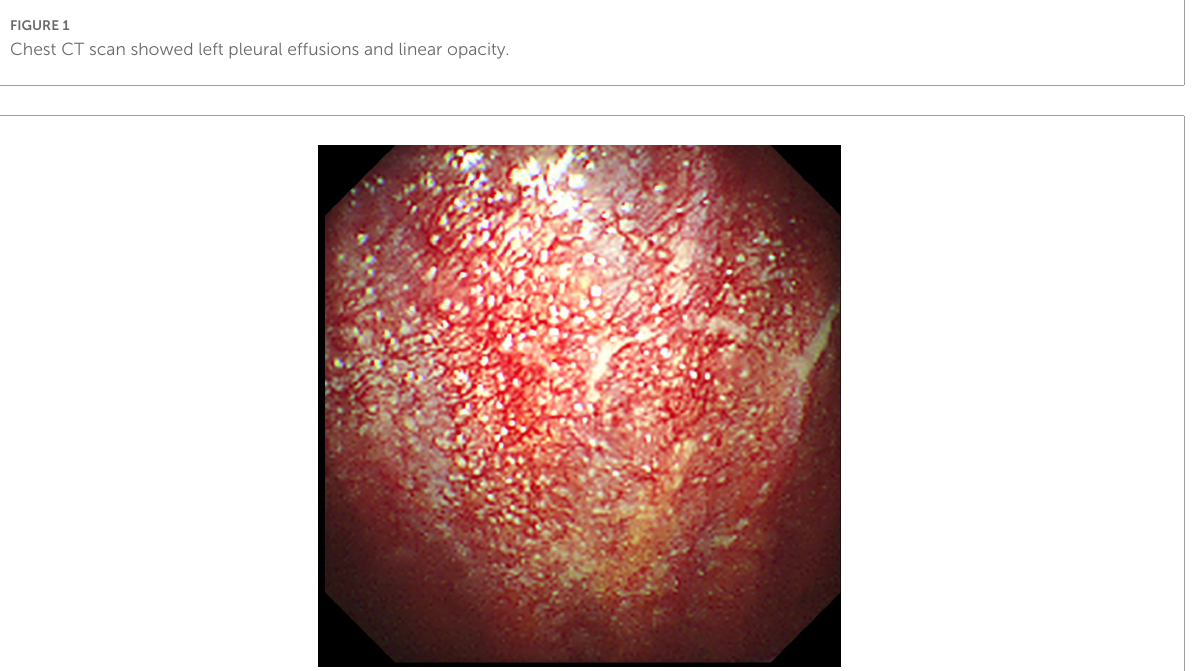
FIGURE2 Thoracoscopy demonstrated amounts of white nodules on the pleurae.